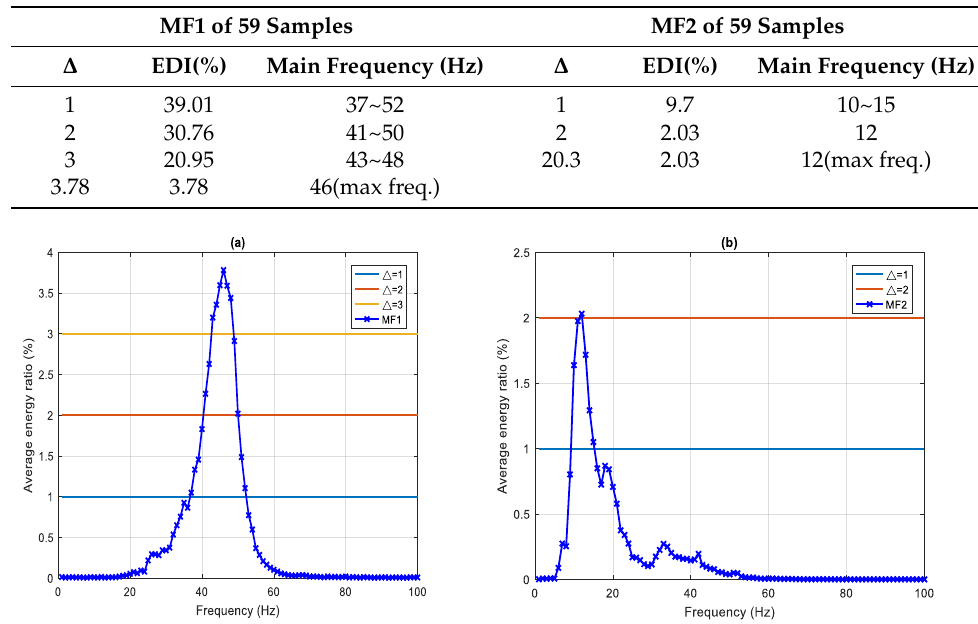
Figure 4. MF of the IMF in 59 samples, average frequency – energy distribution, ( a ) MF1 ( b )